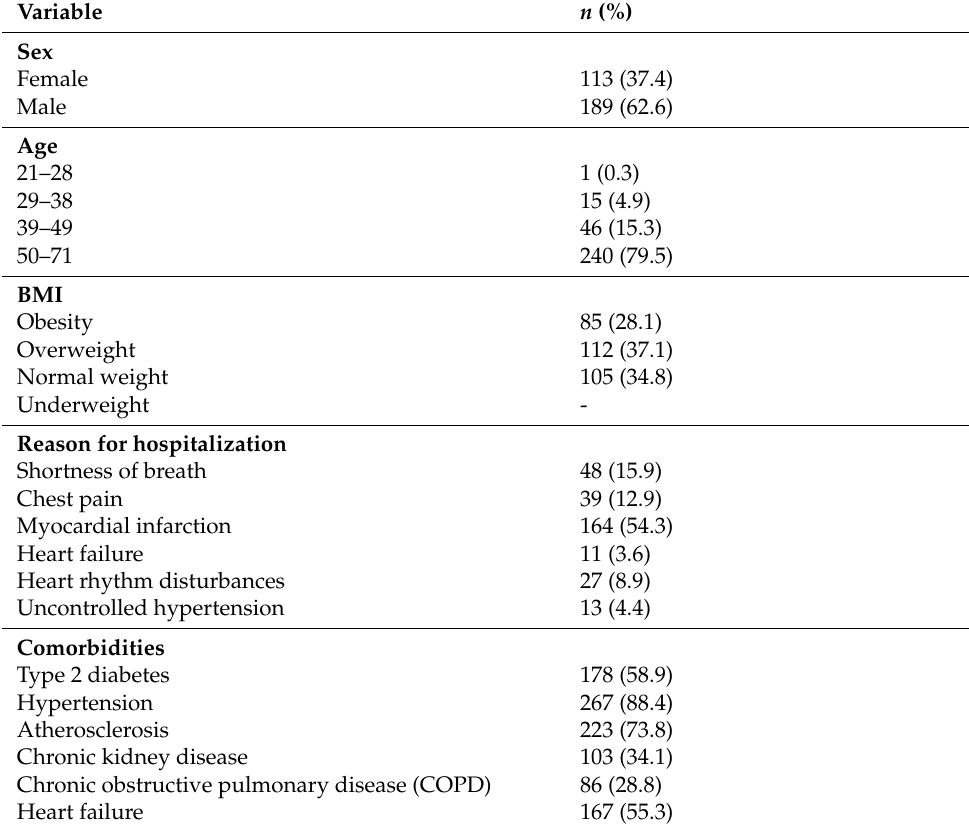
Table 1. Characteristics of the study group ( n =